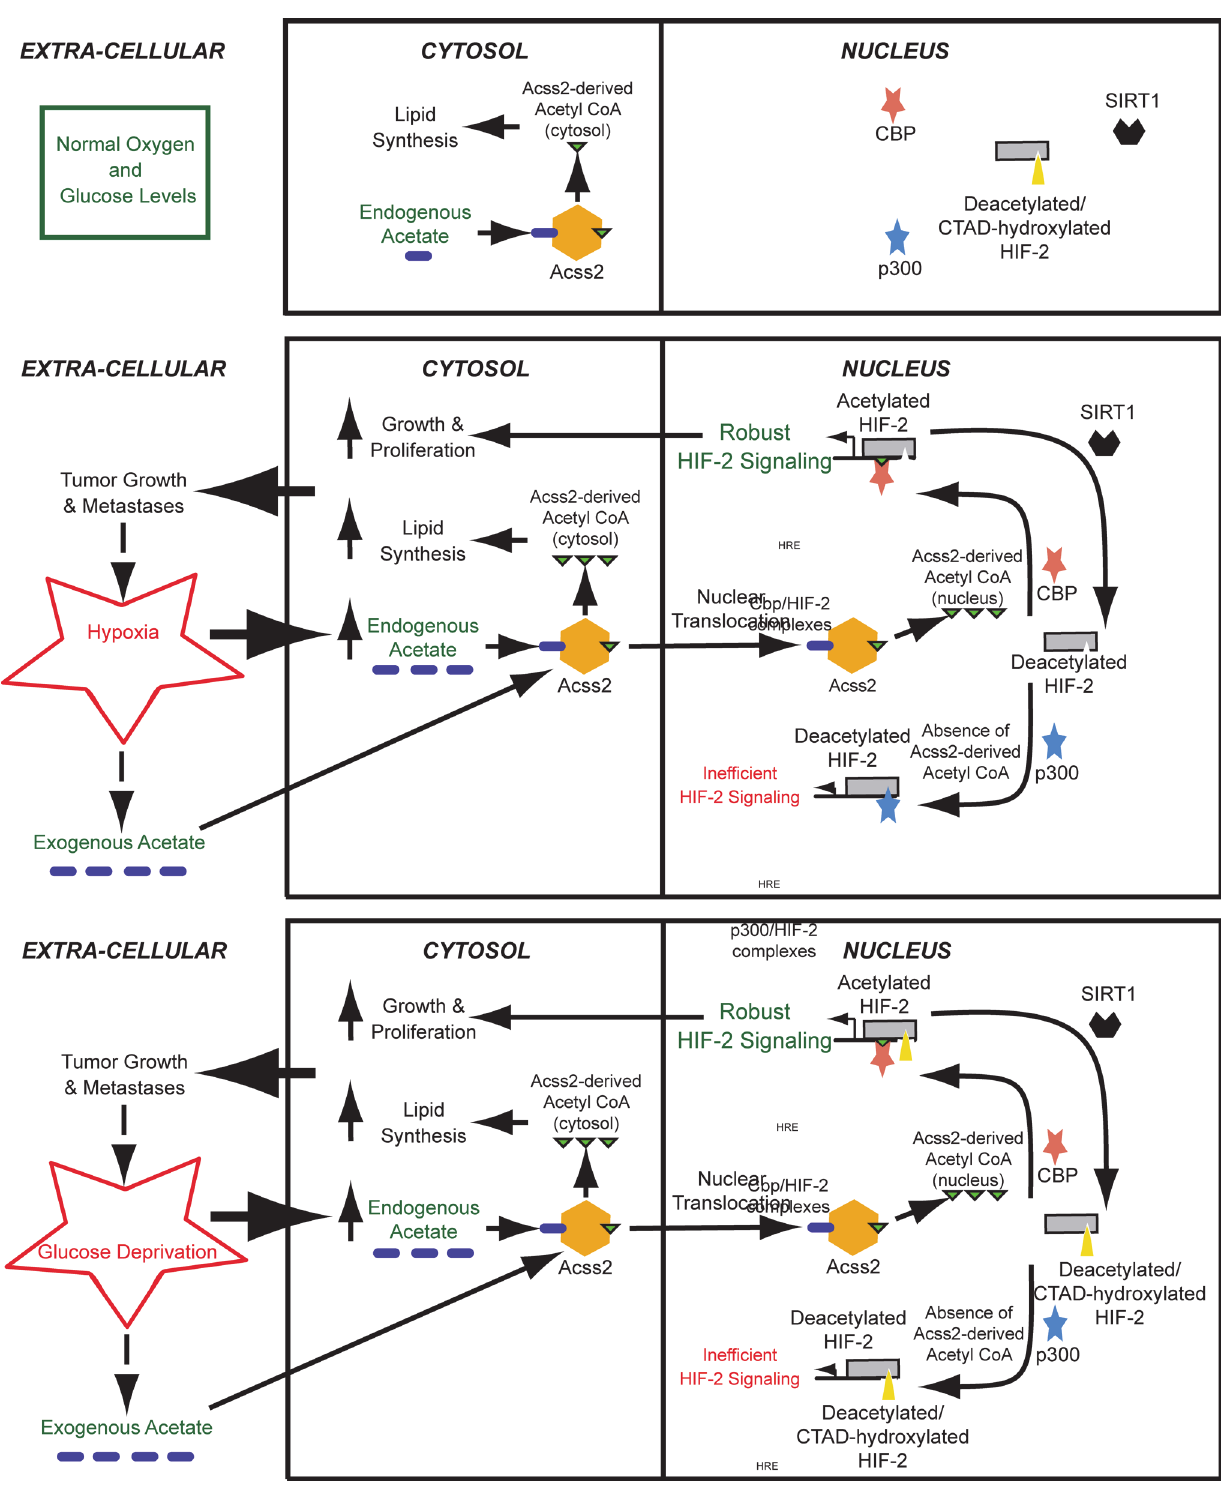
Fig 8. Proposed role of the acetate switch in tumor biology. Endogenous acetate generated in response to hypoxia or glucose deprivation, or exogenous acetate originating from neighboring cells or from gastrointestinal uptake, stimulates ACSS2-dependent acetyl CoA production in the cytosol, but also directs production of an acetyl CoA pool that is localized in the nucleus upon ACSS2 nuclear translocation. In the cytosol, ACSS2 contributes to lipid synthesis, likely for cell growth and proliferation. In the nucleus, the acetyltransferase/coactivator CBP uses this specific ACSS2-derived acetyl CoA pool for HIF-2 α